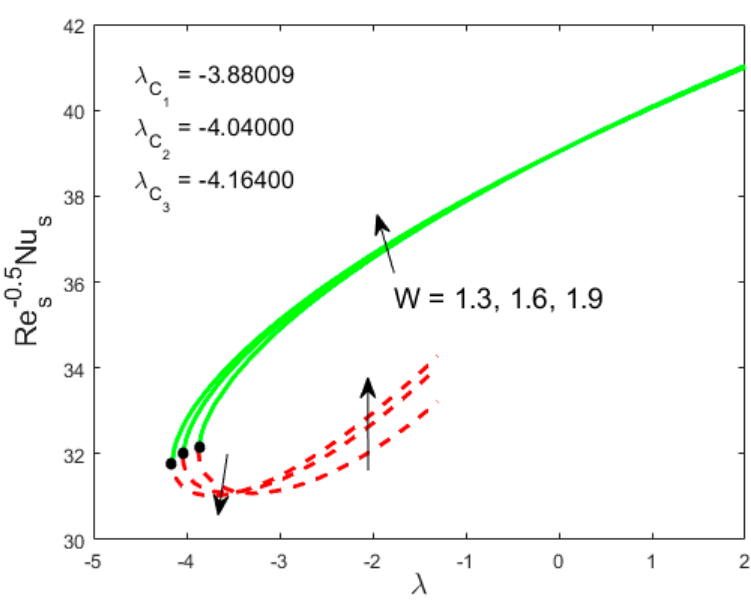
− 0.5 λ 0.5 Re Nu − versus λ . Figure 19. Influence of W on Re s Nu s versus s s 0.5 Re Nu − versus λ . s s